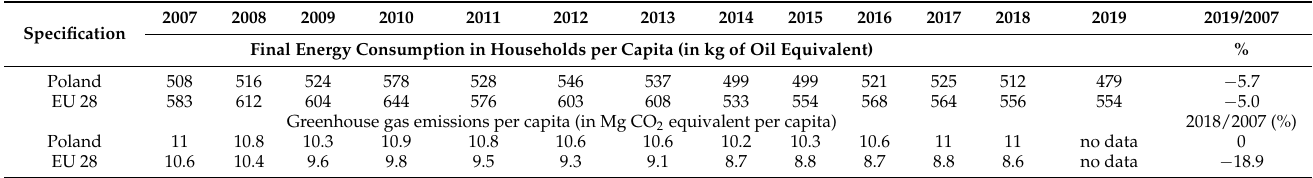
Table 1. Final energy consumption in households and greenhouse gas emissions per capita in Poland and the EU 28 [36].